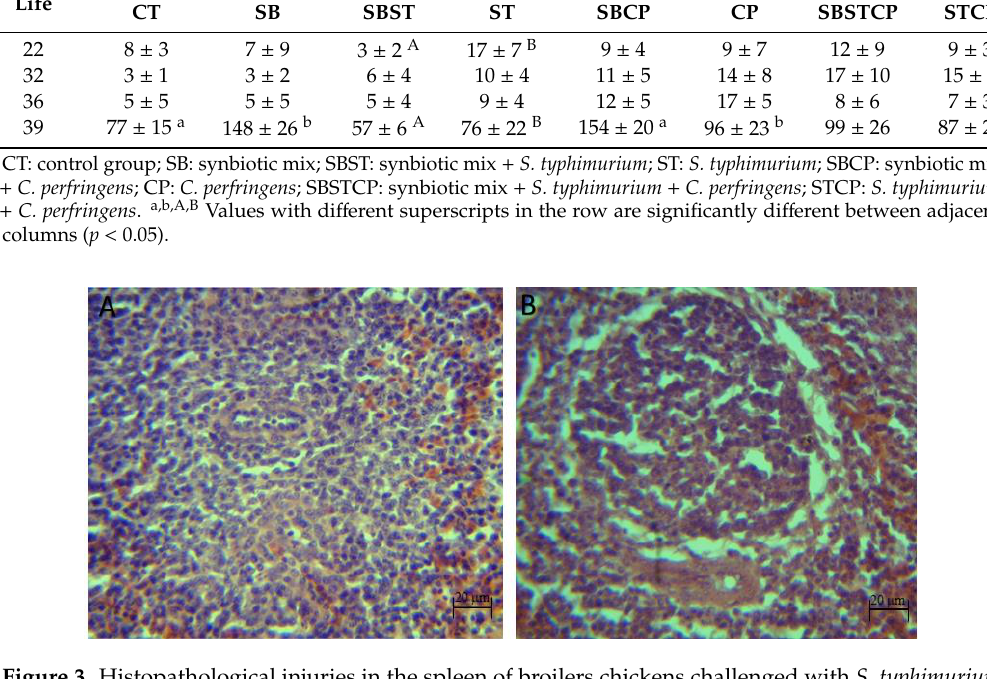
Table 5. Synbiotic effect on the white pulp lymphocyte count of broilers’ spleens challenged with Salmonella typhimurium and Clostridium perfringens. Days of